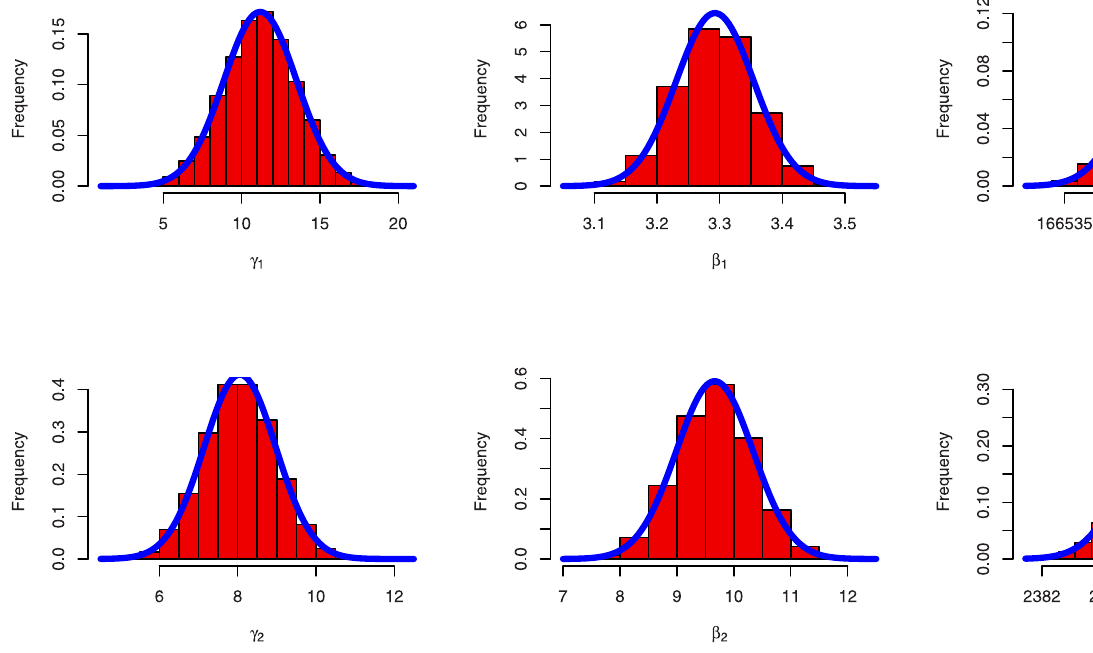
Fig 11. Histogram plot with density posterior curve of MCMC results.